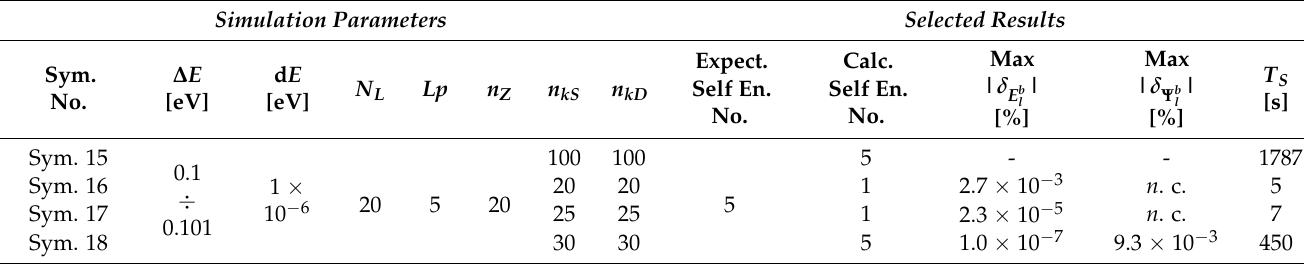
Table 7. Basic parameters and selected results of simulations for structure presented in [3]. Simulation Parameters Selected